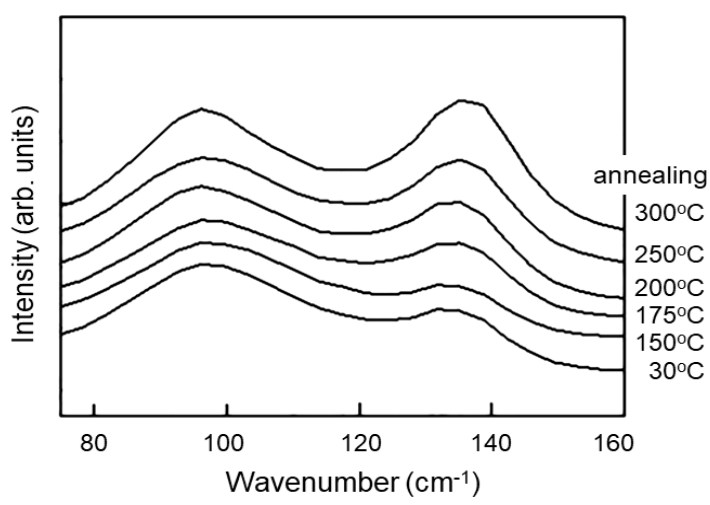
Figure 1. Low wavenumber Raman spectra of PEEK films annealed at various temperatures (measurement at room temperature).